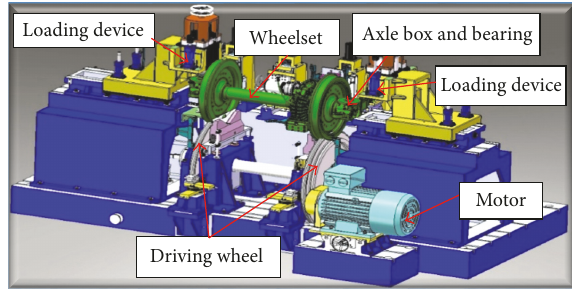
Figure 8: Schematic sketch of the wheelset bearing test